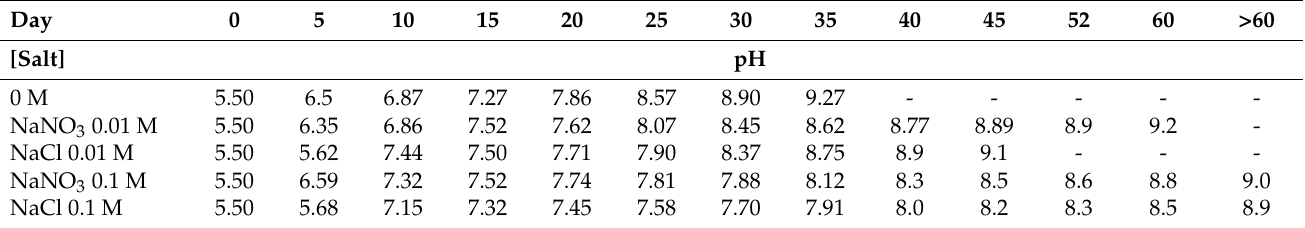
Table 3. Lifetime of PIM